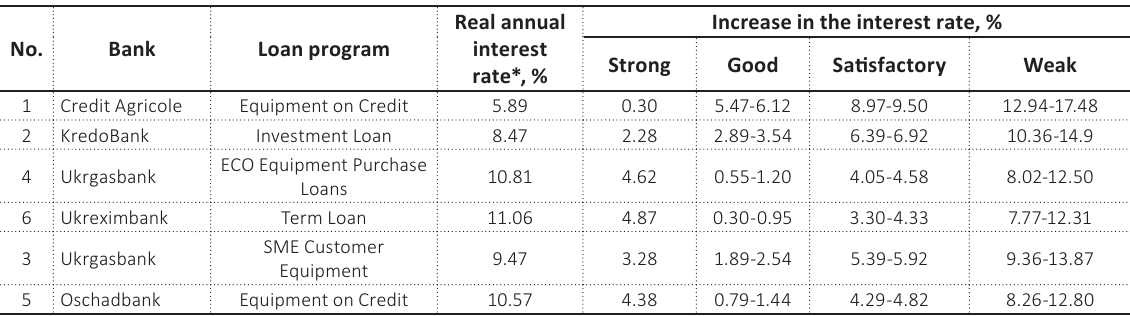
Table 3. Range of increasing the loan rate for an investment project based on the target financial covenants (DSCR i and LLCR), % of borrowers